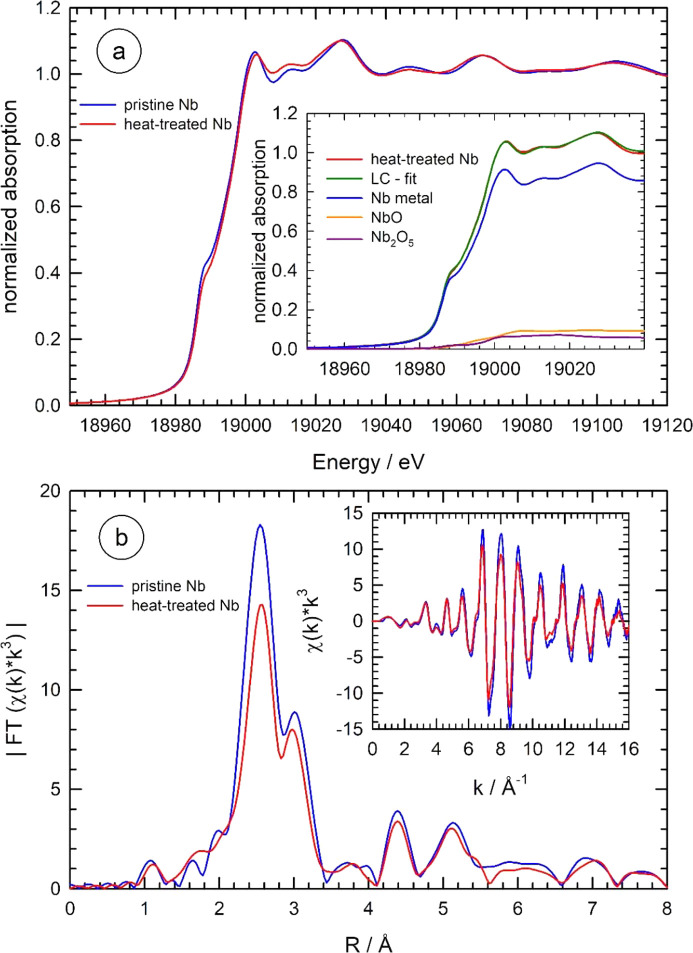
(a) XANES spectra of an Nb metal foil (25 µm thickness) at room temperature prior to any heat treatment (blue line) and after a heat treatment in an Anton Paar DHS 1100 cell at 900°C for one hour and cooling-back to room temperature (red line). The inset depicts a linear combination fit of the XANES of the heat-treated sample using reference spectra of an Nb metal foil, NbO and Nb2O5, leading to 85.0 ± 0.7% Nb metal, 9.3 ± 0.8% NbO and 5.7 ± 0.7% Nb2O5, respectively. (b) Magnitude of the Fourier-transform |FT[χ(k)k
3]| of the k
3-weighted EXAFS fine structures χ(k)k
3 measured for the pristine Nb foil (blue line) and the heat-treated foil (red line) (k-range for the FT: 2.2 Å−1 < k < 14.5 Å−1, data not corrected for phase shifts). In the inset, the k
3-weighted fine structure oscillations are presented for both data sets.